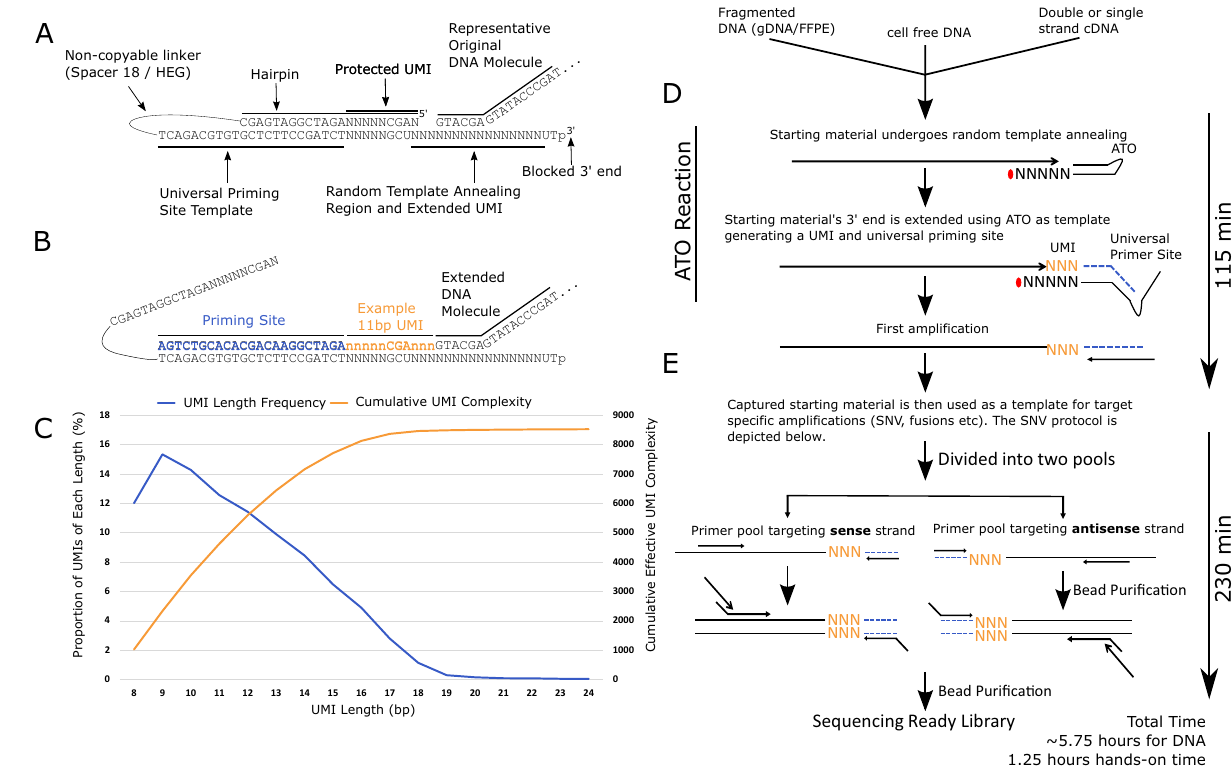
Figure 1. Overview of ATOM-Seq approach and targeted enrichment protocol. ATOM-Seq based protocols can take any suitable starting material including cell-free DNA, fragmented FFPE DNA, or cDNA. ( A ) A detailed overview of an ATO and its annealing to a representative DNA molecule. ATOs consist of a blocked 3 ′ end preceded by a U nucleotide, a 15 bp string of Ns to act as the random annealing site and as part of the UMI, a double strand stem region containing a protected 8 bp UMI and a universal priming site. The two strands of the stem are linked by a non-DNA spacer. ( B ) A representative product of an ATO Reaction where a DNA molecule was extended on an ATO template, generating an 11 bp UMI. ( C ) In blue, a frequency distribution analysis of UMI length, starting from the minimum 8 bp protected UMI. In orange, the cumulative complexity of the random region generated during the 3 ′ extension reaction, taking into consideration the increasing potential complexity but declining frequency of longer UMIs. ( D ) Protocol overview. The first step is an “ATO Reaction” which captures the starting material by extending their 3 ′ ends using an ATO as a template, generating a Unique Molecular Identifier and a universal primer site. ( E ) Target enrichment is accomplished by dividing the first amplification into two separate pools for two rounds of nested PCR. Each pool targets either the sense or antisense DNA strands allowing both strands to be independently